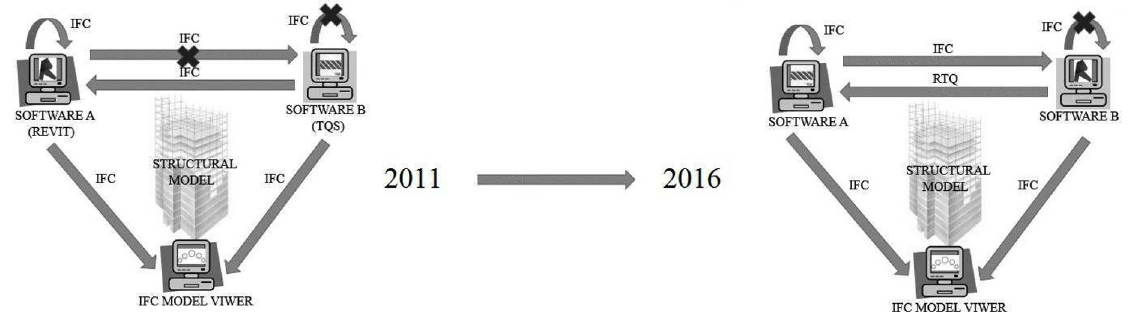
Fig. 8. Model transfers in the experiments: on the right, the first experiments transfers are show; on the left, model transfers from the second experiment can be seen (the transfers not executed are marked with an X)